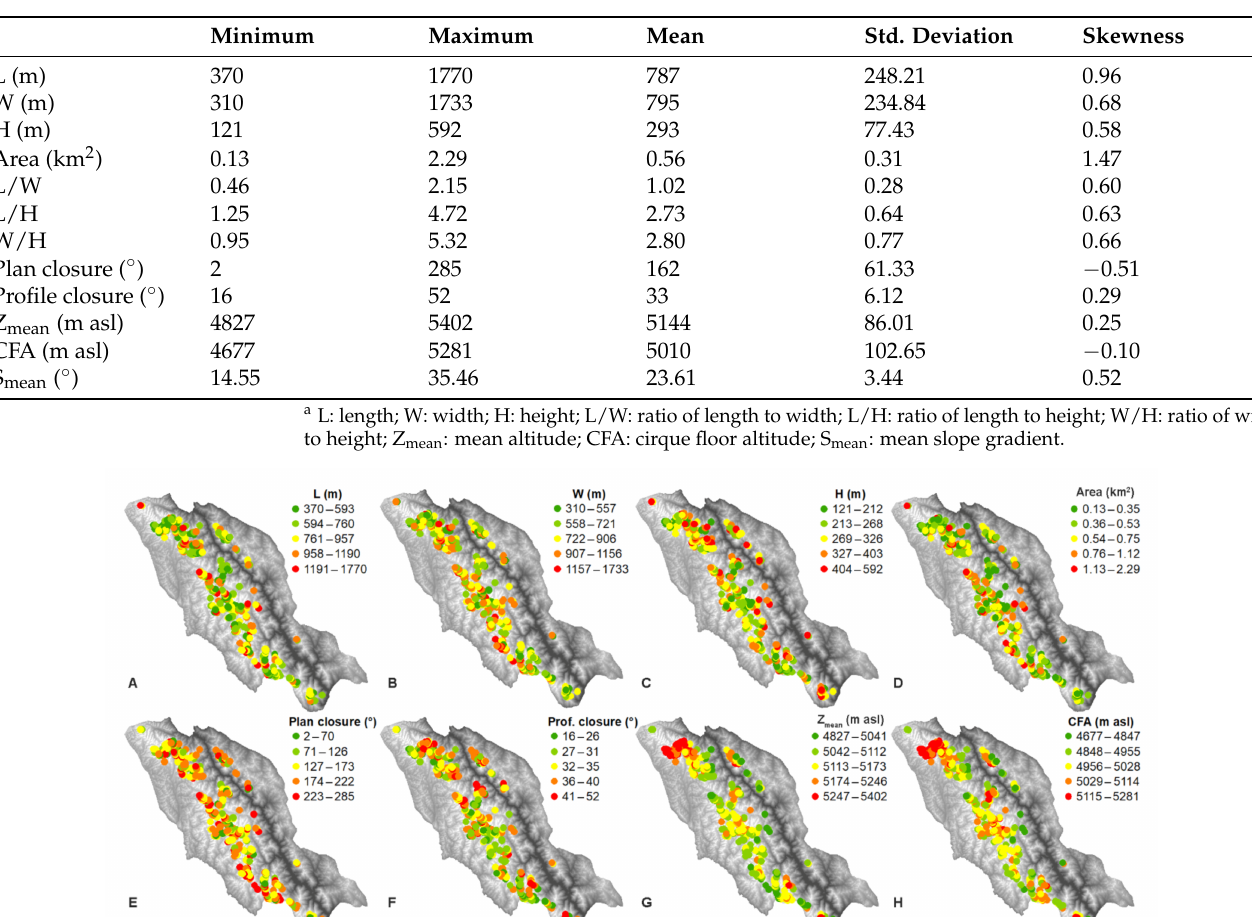
Table 1. Descriptive statistics of the cirque metrics of the study area a .